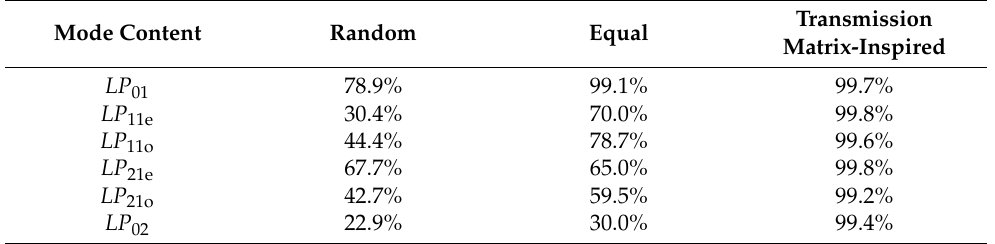
Table 1. The stabilized mode content using different methods for initializing amplitudes.